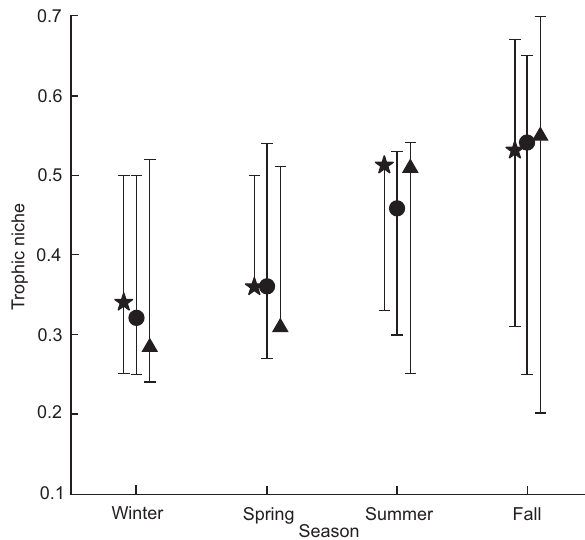
Figure 2. Temporal variation in the amplitude of the trophic niche (Shannon-Weiner) and confidence intervals for all adults of Lithobates catesbeianus (circles), females (star) and males (triangle) between July 2008 and May